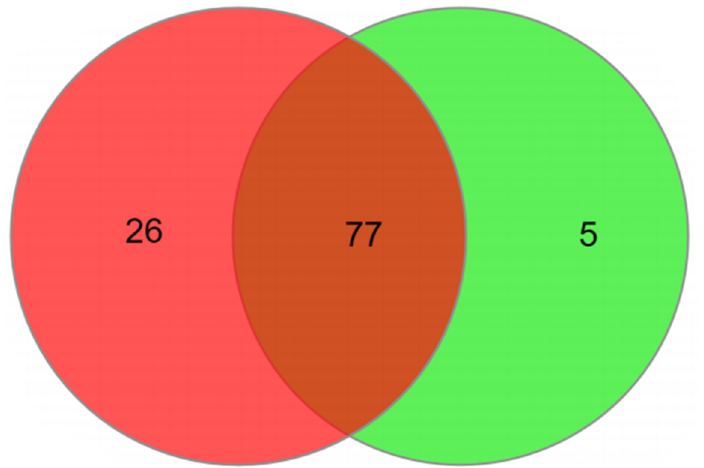
Figure 1. Venn diagram for salivary metabolites probed on OSCC (red) and control (green) groups. Table 3. Exclusive and shared salivary metabolites for OSCC and control groups.